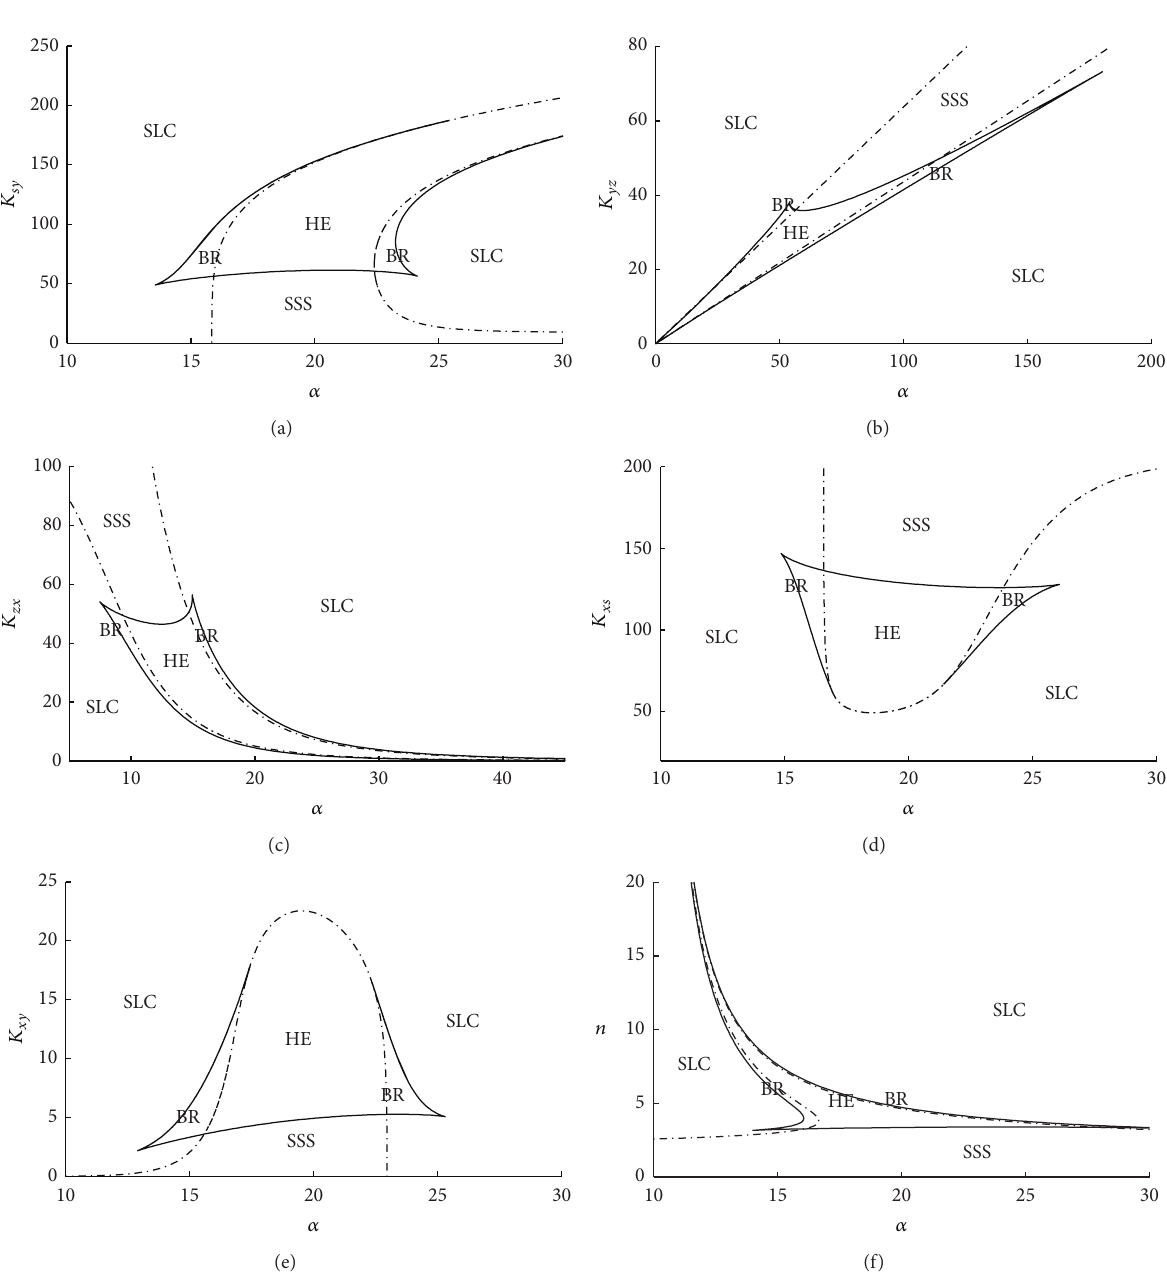
Figure 11: Bifurcation diagram of parameter 𝛼 versus parameters 𝐾 𝑠𝑦 , 𝐾 𝑦𝑧 , 𝐾 𝑧𝑥 , 𝐾 𝑥𝑠 , 𝐾 𝑥𝑦 , and 𝑛 for model